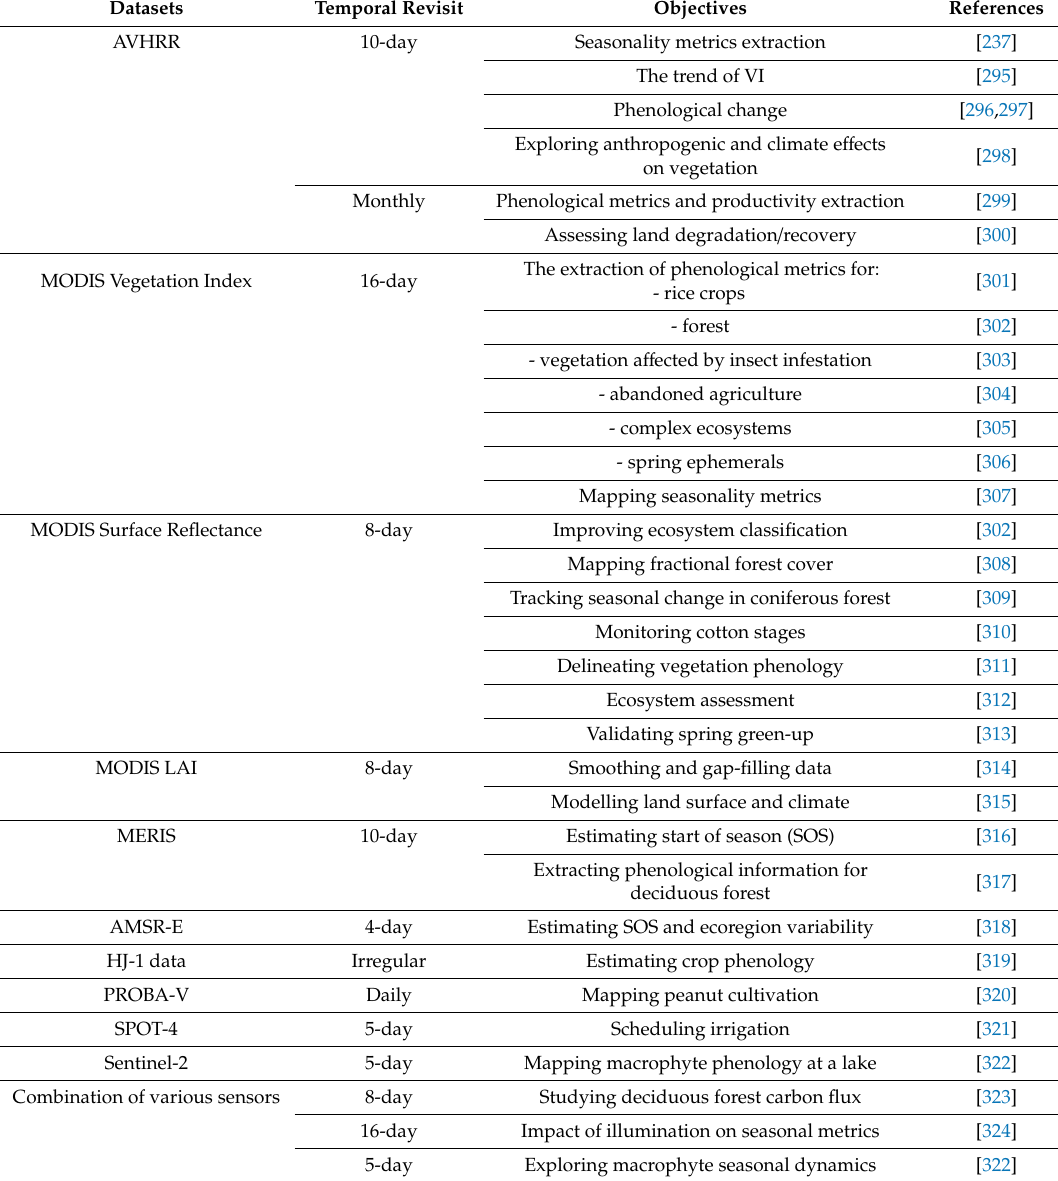
Table 6. Remote sensing investigations employing